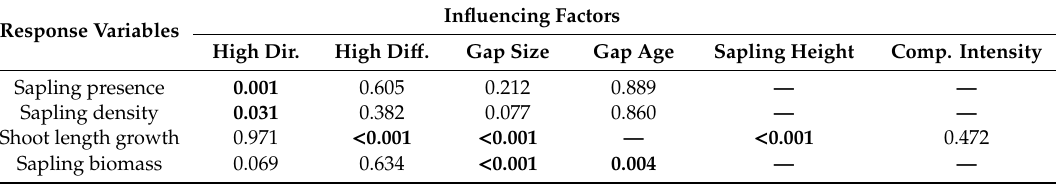
Table 2. Summary of ANOVA results ( p -values) of generalized linear mixed e ff ects models (GLMM) on the influence of higher levels of direct or di ff use radiation, gap size and gap age, and sapling height and competition intensity on sapling abundance or performance. Sapling density and presence or absence were modelled together in a zero-inflated GLMM using a negative binomial distribution in the complete sample of 229 plots (squares of 4 m 2 size). Influence on the log biomass per ground area in the subsample of 179 plots with regeneration was modeled with a GLMM with a Gaussian distribution. Shoot length growth was modeled for 151 plants as well with a GLMM with a Gaussian distribution. Significant results ( p ≤ 0.05) are printed in bold. Factors that were not considered in the respective model are marked by